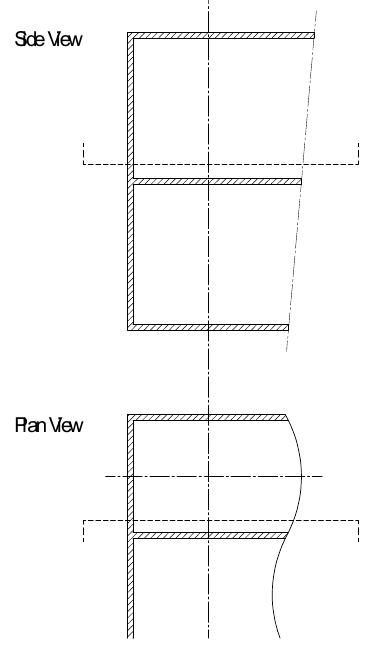
Fig. 8 Sketched contour for a façade with bent